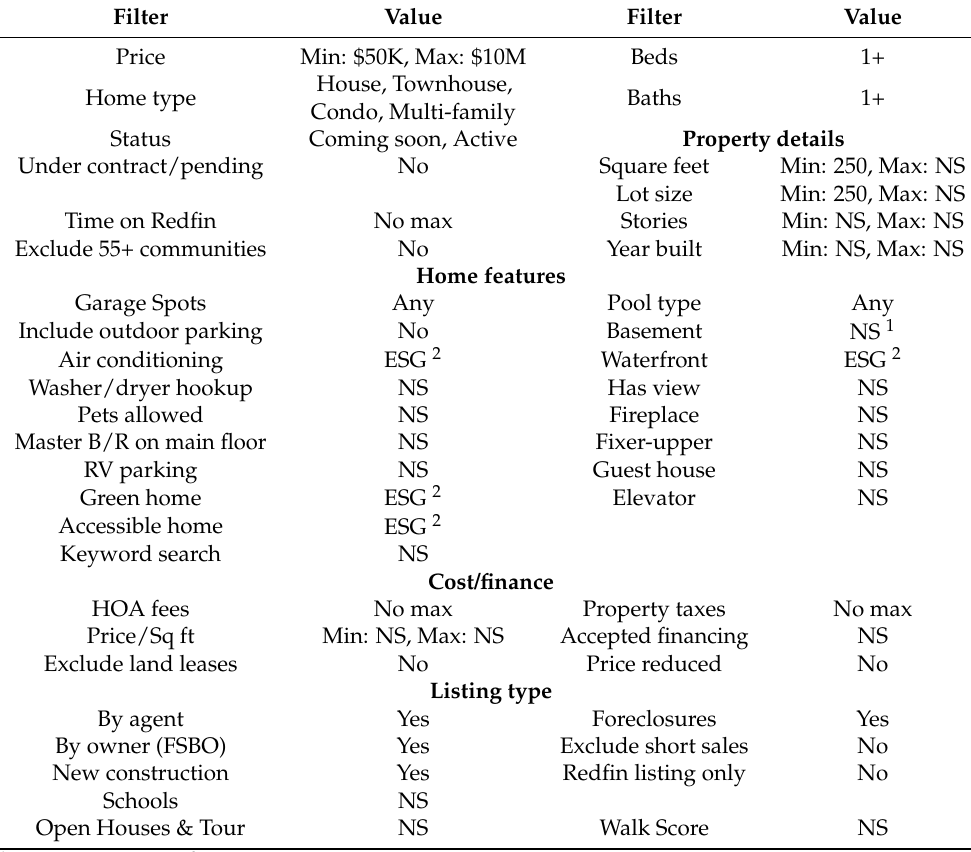
Table A1. Filter settings used in accessing Redfin